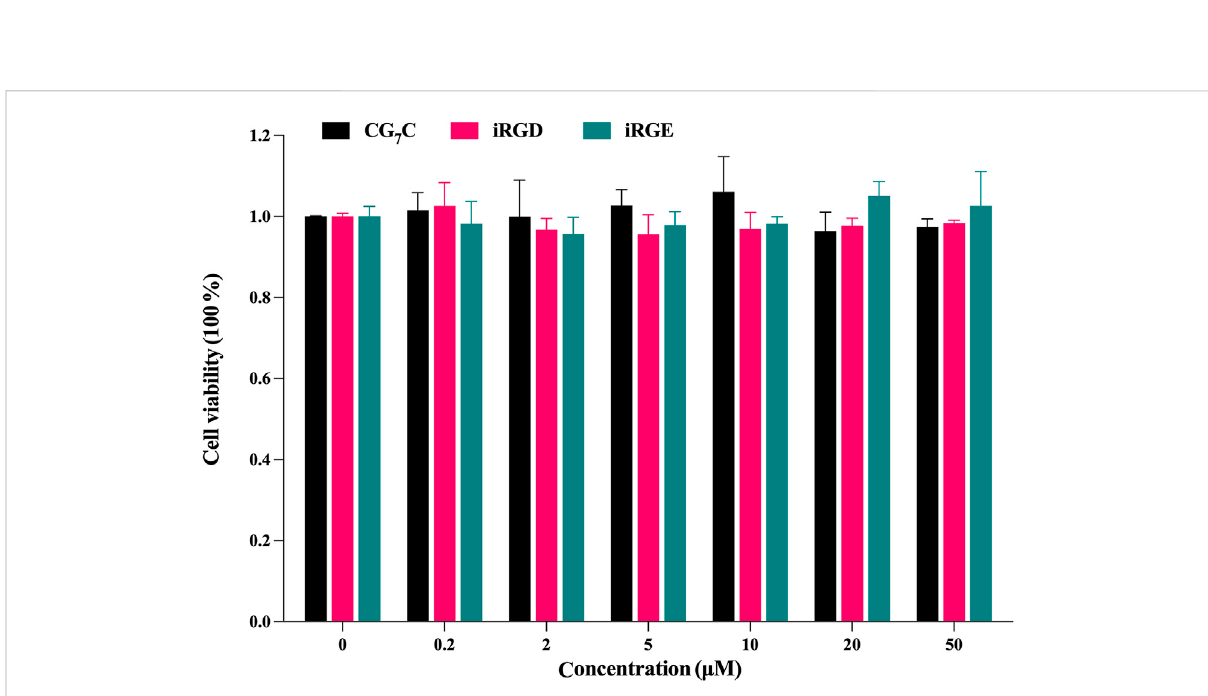
FIGURE 2 Cytotoxic effects of CG 7 C, iRGD, and iRGE on 4T1 cells at concentrations from 0 to 50 μ M after incubation for 24